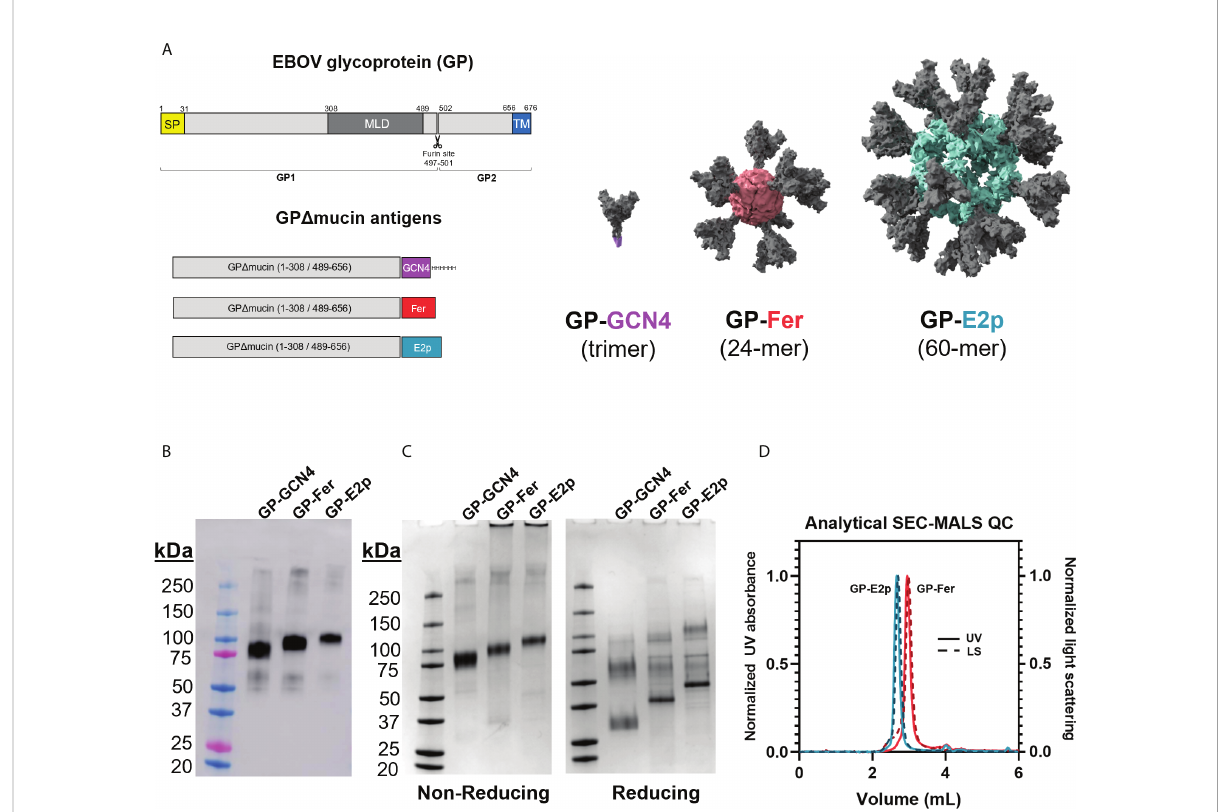
FIGURE 1 Protein nanoparticles functionalized with GP D mucin can be expressed in mammalian cells and puri fi ed to homogeneity. (A) GP D mucin antigens were designed using the Ebola virus (Mayinga, Zaire, 1976) sequence. The domains of GP are shown in the top schematic and indicate the relative positions of the signal peptide (SP), the mucin-like domain (MLD), and the transmembrane domain (TM). GP D mucin soluble antigens were designed by removing the sequence encoding amino acids 309-488. The TM domain was also removed and replaced with either a GCN4 trimerization domain (GP-GCN4), a ferritin subunit (GP-Fer), or an E2p subunit (GP-E2p). For the GP-Fer and GP-E2p constructs, an SGG linker was inserted in between GP D mucin and the nanoparticle subunit. (B) Expi supernatants from cells expressing GP-GCN4, GP-Fer, and GP-E2p were blotted for the presence of antigen using mAb114, a GP1-reactive monoclonal antibody. Western blots indicated that expression levels were not perturbed by nanoparticle functionalization of GP D mucin. (C) GP D mucin were assessed for purity using SDS-PAGE analysis under non-reducing (left) and reducing (right) conditions and stained with GelCode Blue stain. Non-reducing conditions yield a single band whereas reducing conditions show multiple species, indicating that GP D mucin antigens are cleaved at the native furin site between GP1 and GP2. (D) SEC-MALS analysis of GP-E2p and GP-Fer following puri fi cation indicate that the nanoparticles are homogenous and do not exhibit